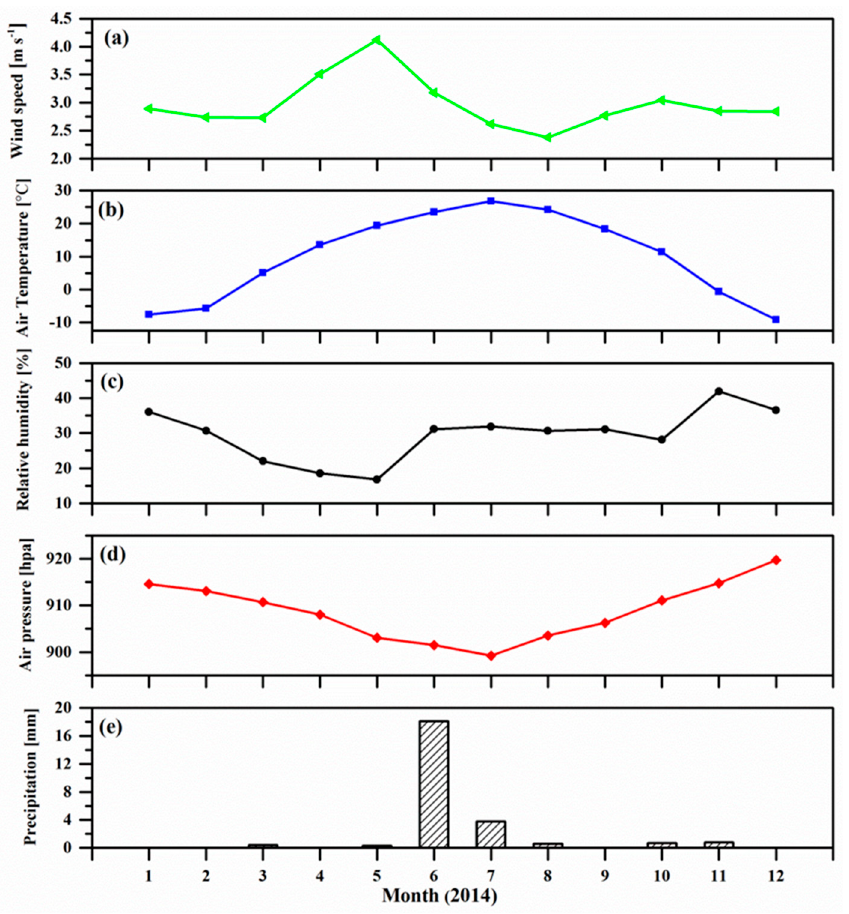
Figure 3. Monthly averages of ( a ) wind speed, ( b ) air temperature, ( c ) relative humidity, ( d ) pressure, and ( e ) monthly cumulative precipitation in 2014. Measurements of the wind speed, air temperature, and relative humidity were taken at 10 m height at